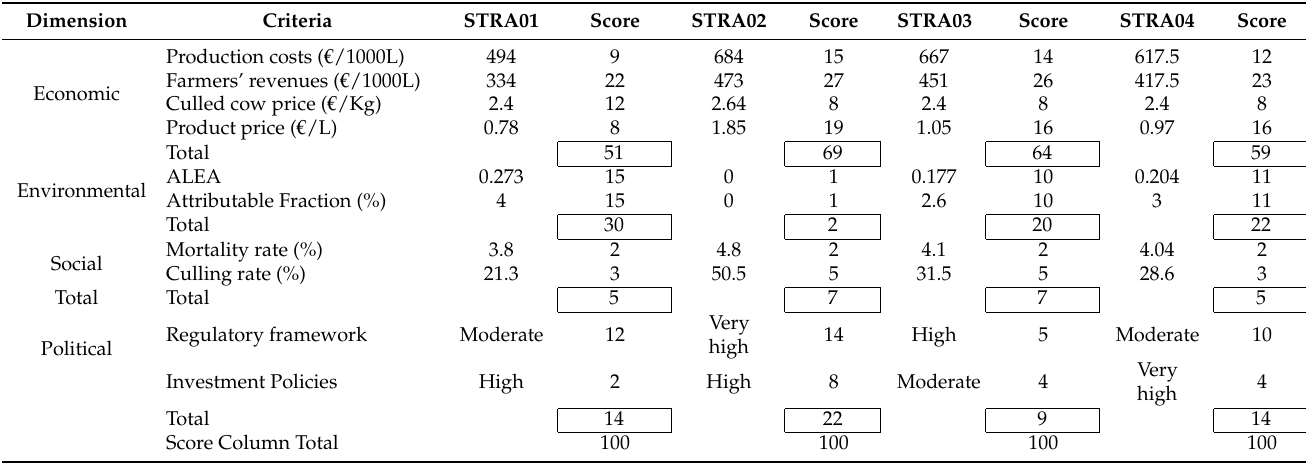
Table A1. Example of the preference evaluation grid to be completed by multi-criteria decision analysis